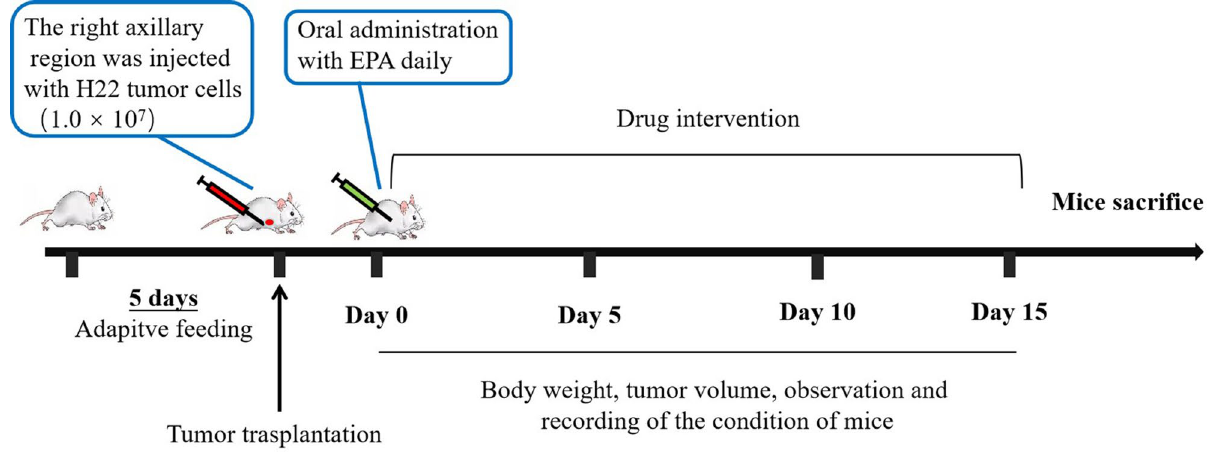
Figure 16. Anti-tumor experimental design scheme of H22 in